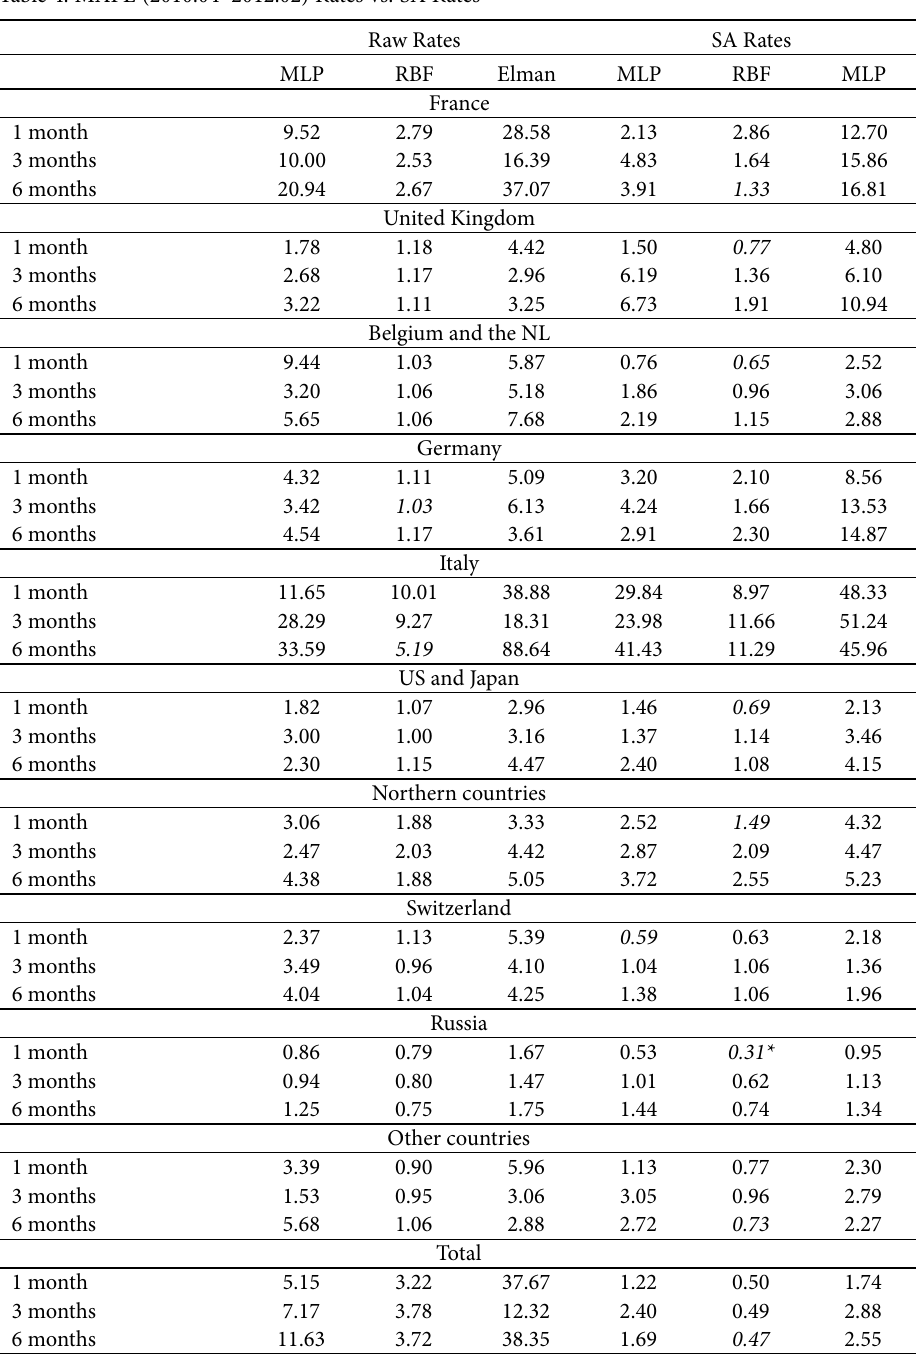
Table 4. MAPE (2010:04–2012:02) Rates vs. SA Rates